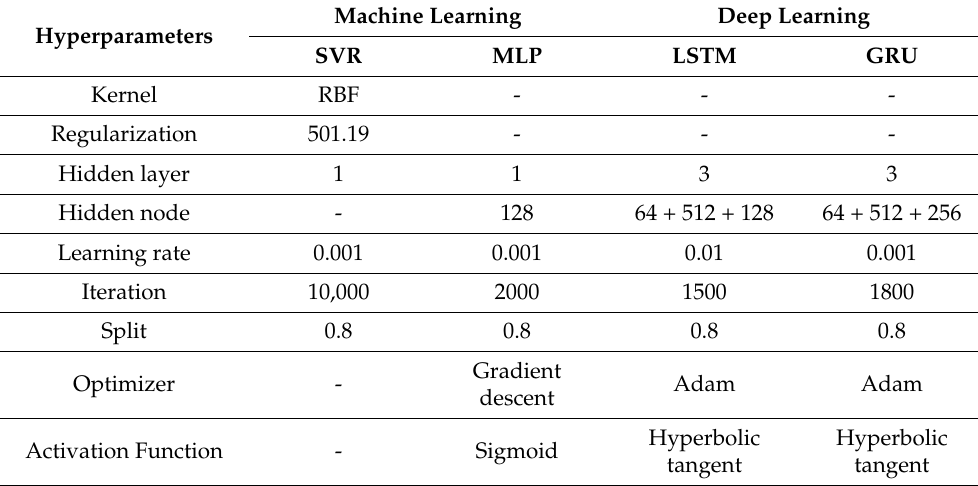
Table 6. Hyperparameters Implemented in the Prediction Task.